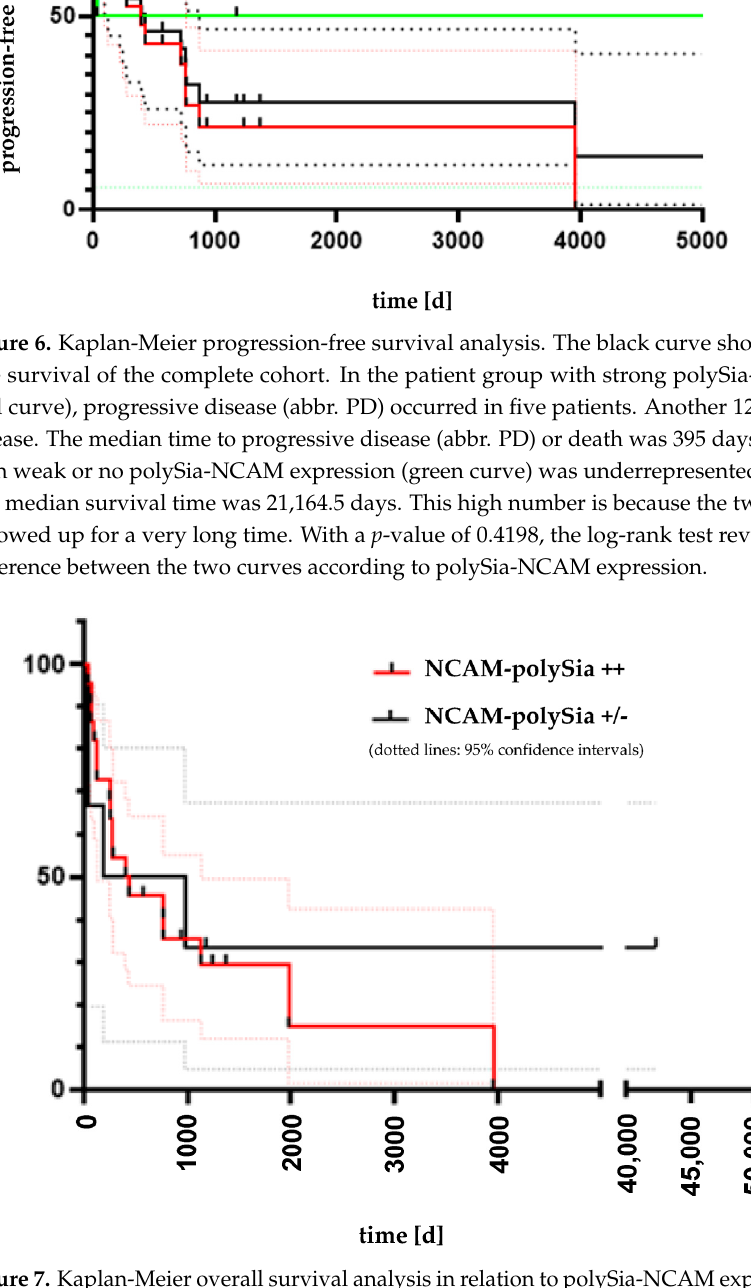
Figure 7. Kaplan-Meier overall survival analysis in relation to polySia-NCAM expression. The patient group with strong polySia-NCAM expression (red curve) included 22 patients. Of these, 17 patients died within the observation period of the study. The median survival time in the strongly polySia-NCAM positive group was 411 days. The patient group with no or weak polySia-NCAM expression (black curve) included 6 patients, 4 of these patients died from disease. The median survival time was 578.5 days. The log-rank test showed no significant difference between the two curves according to polySia-NCAM expression. ( p = 0.6918).